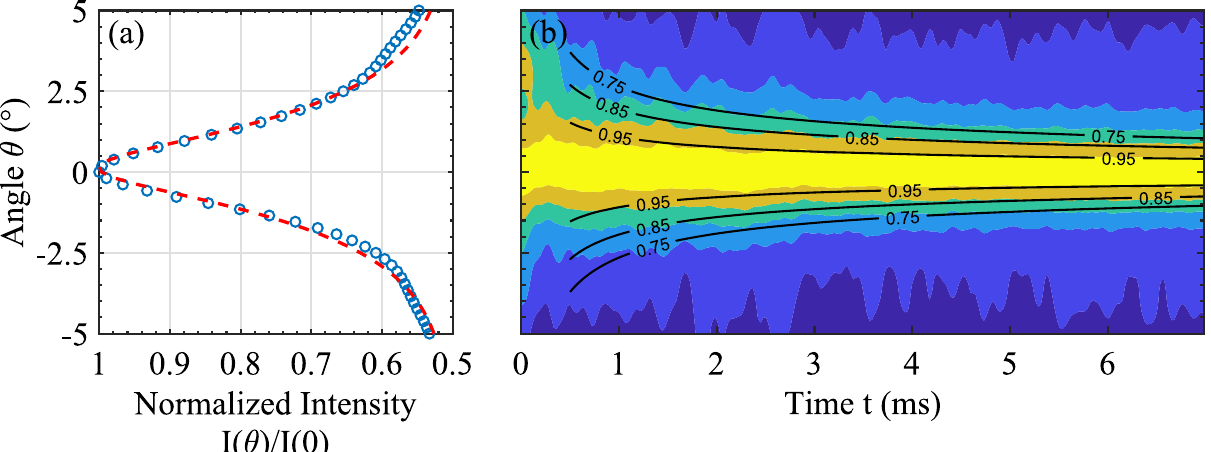
Figure 1. ( a ) Stationary CBS profile (blue open circles) fitted with the diffusion theory (red dashed line). ( b ) Dynamic CBS profile fitted with the diffusion theory (black solid lines). In ( b ), the intensity is normalized by its peak value at each time to show more clearly the temporal evolution of the